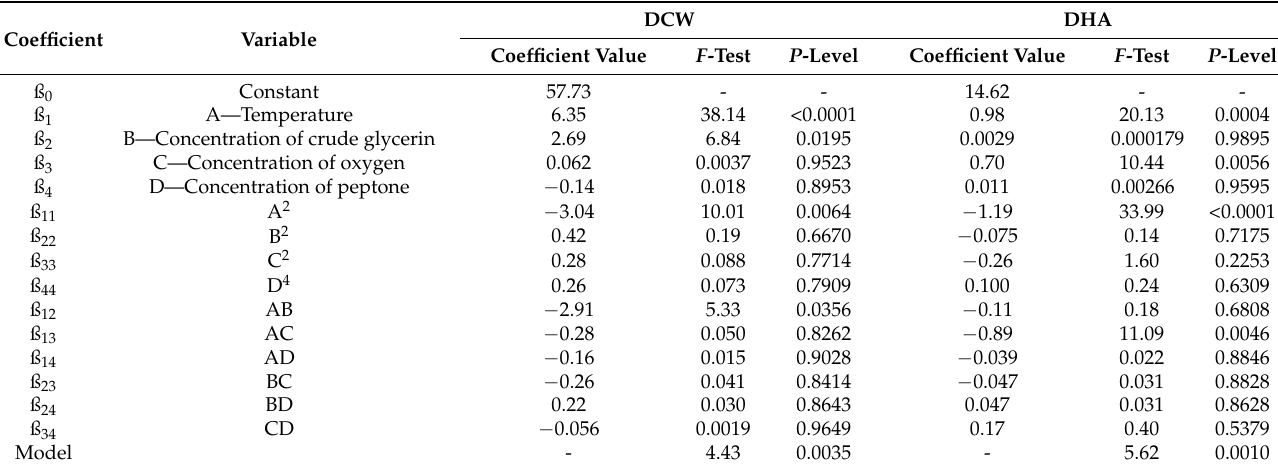
Table 9. Second-order polynomial equation coefficient values, with related F-test and P-test results.